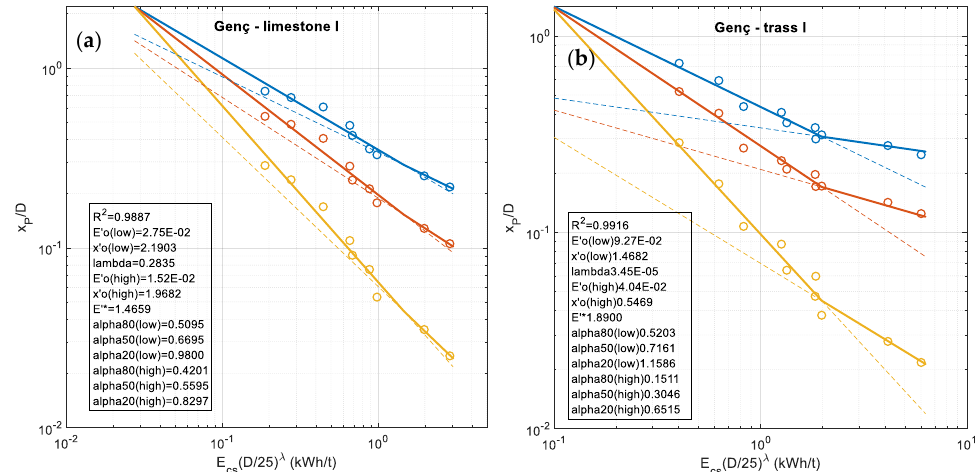
Figure A3. Double fans for Genç ’s et al. [ 24] limestone I ( a ) and trass I ( b ). Solid lines are the actual high- and low-energy percentile lines, dashed lines are extrapolations out of their ranges of validity. Circles are data. Percentiles colors: blue — 80 %, red — 50 %, yellow — 20 %.